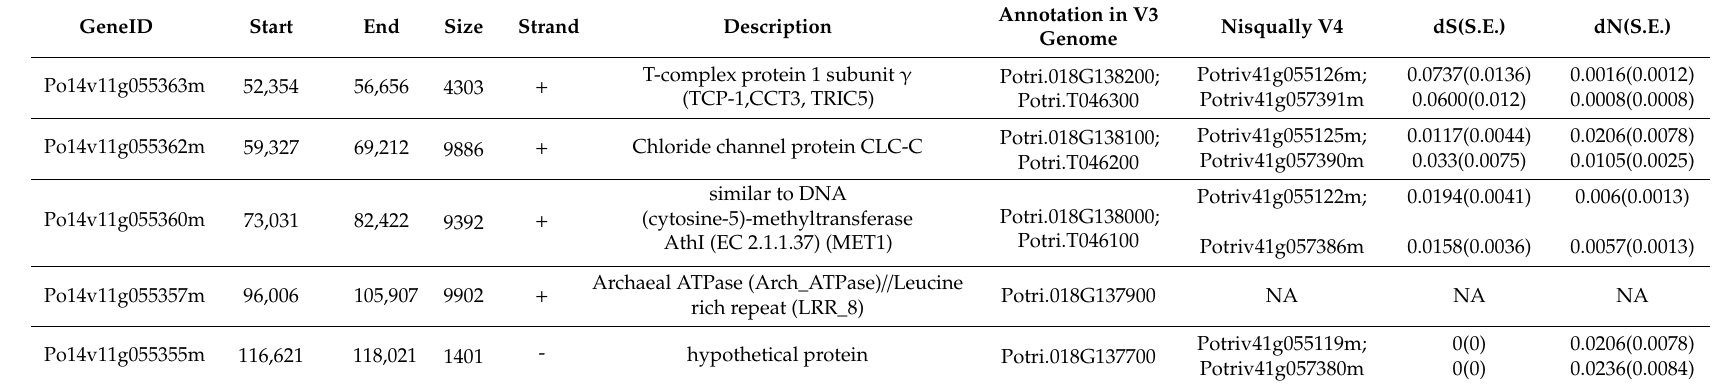
Table 3. Annotated genes in the SDR on the Y-linked contig in Stettler-14 with their homologous genes in other P. trichocarpa